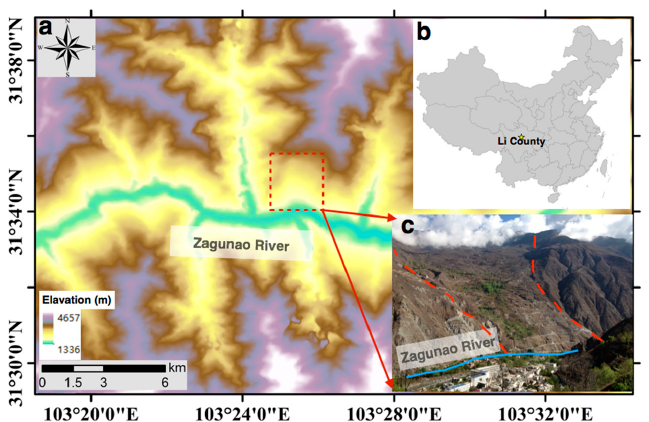
Figure 1. ( a ) Location of the Xishancun Landslide outlined in a red rectangular overlaid by an ASTER DEM; ( b ) location of Li County in China; ( c ) m of the Xishancun Landslide as seen from a terrestrial photo taken from the opposite bank of Zagunao River.